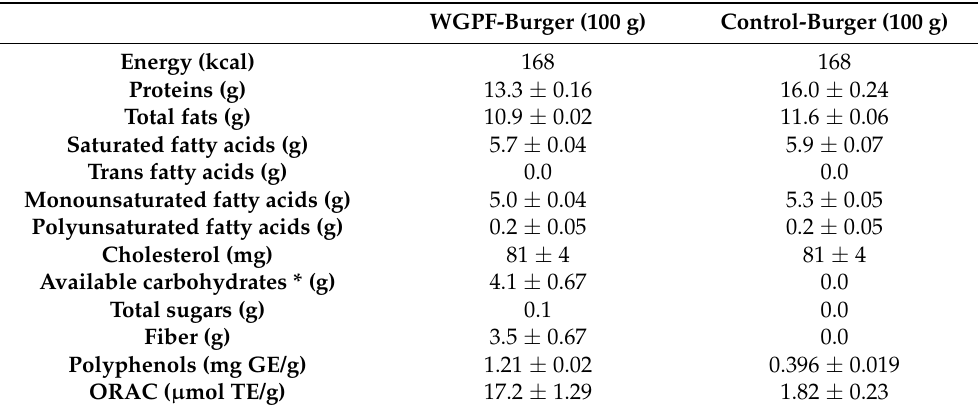
Table 1. Composition of